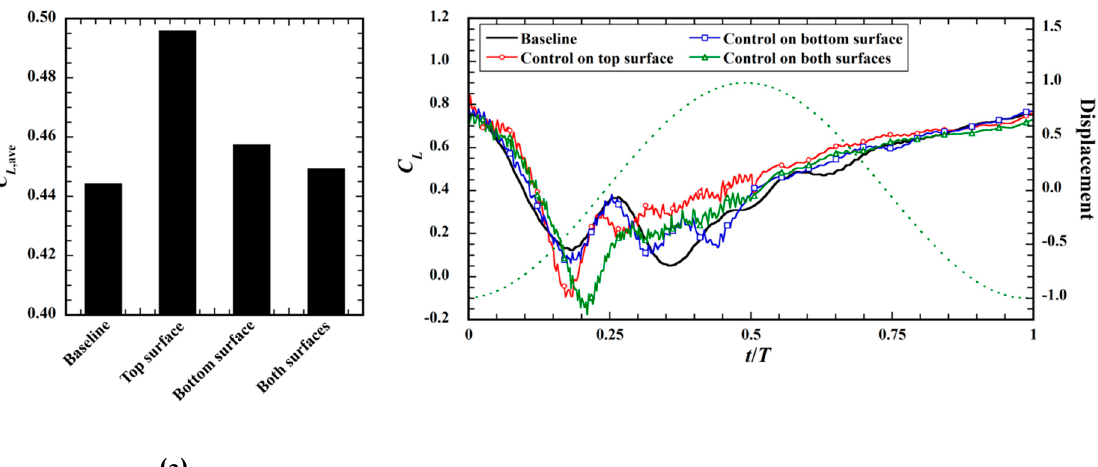
Figure 14. The lift coefficient for the baseline and controlled cases for each installation surface. ( a ) The time-averaged lift coefficient; ( b ) The time fluctuations of lift coefficient during the time period of the oscillation, where the dashed line represents the displacement of oscillating plate without the dimension of amplitude.